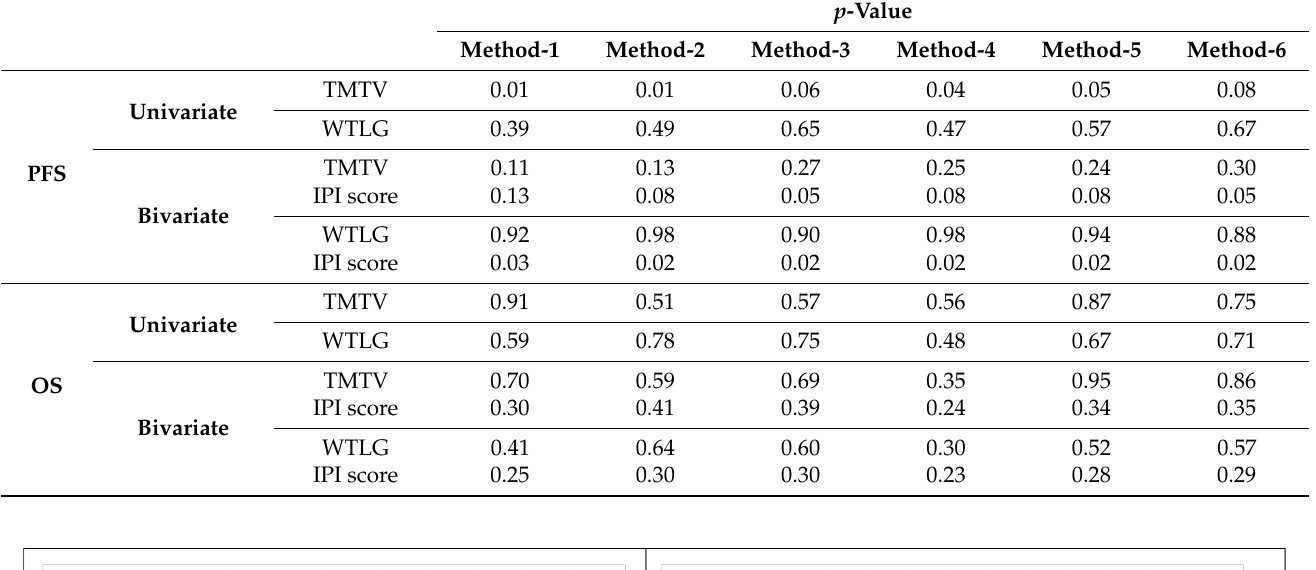
Table 2. Univariate and bivariate Cox-regression models for the association of TMTV and WTLG with progression-free survival (PFS) and overall survival (OS), for the different segmentation methods.